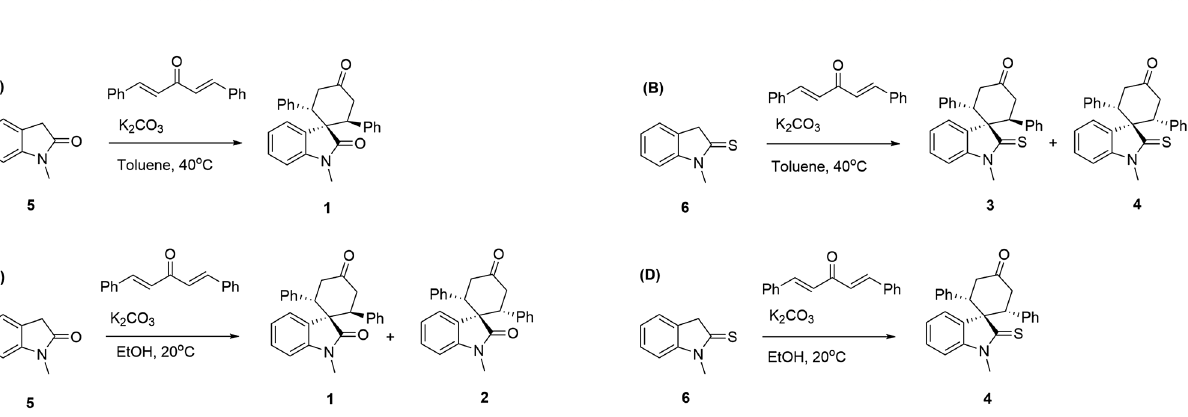
Figure 6. Double Michael addition reaction of N-methyloxindole and N-methylthiooxindole on dibenzalacetone in different